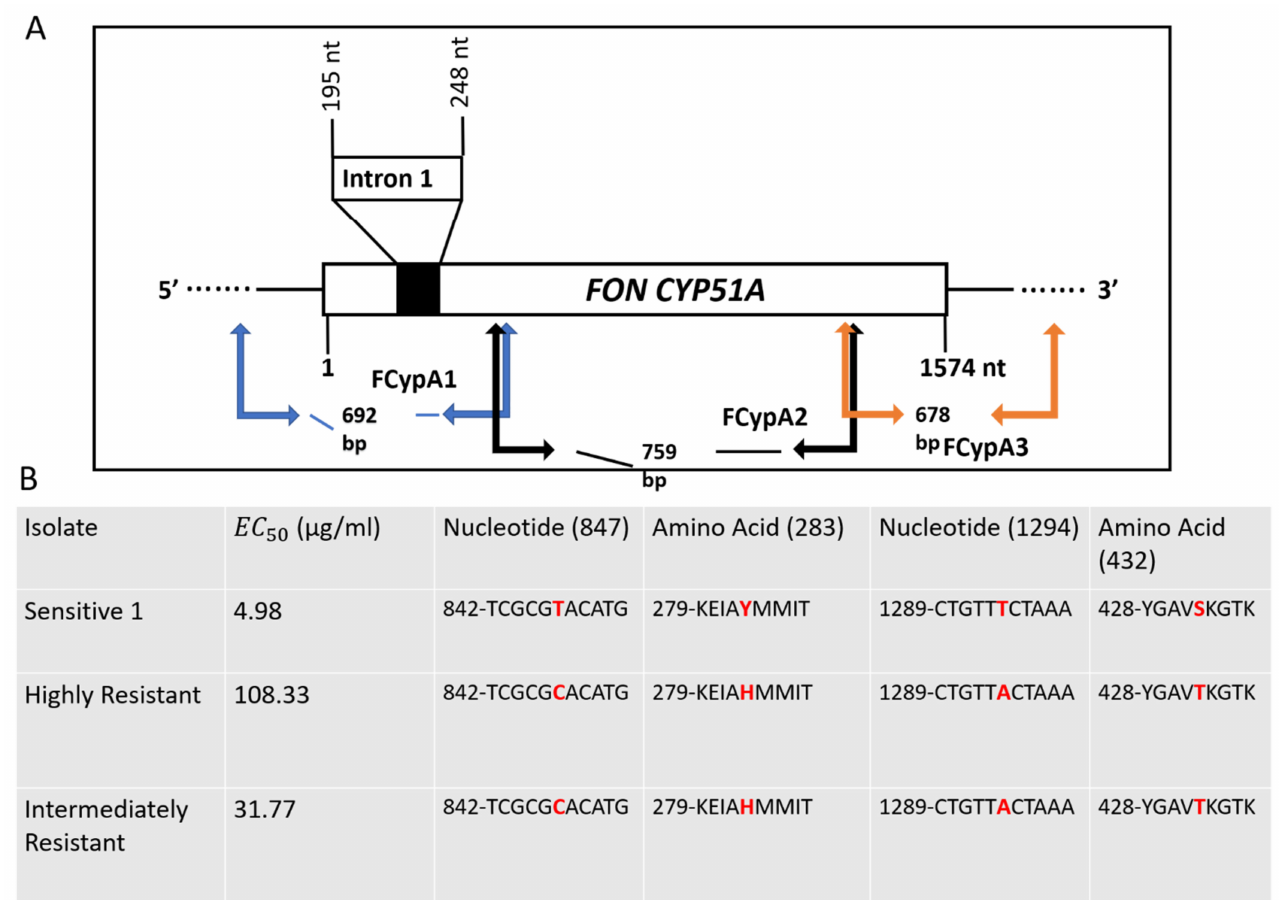
Figure 3. CYP51A gene schematic and detected mutations. ( A ) Intron and exon organization of CYP51A . Primers used for sequencing this gene are written in blue, black, and orange. ( B ) Table with isolates’ group mean EC 50 values and mutation locations of each isolate group. Amino acids that changed from sensitive to resistant are highlighted with colored text (blue = nucleotide, red = amino